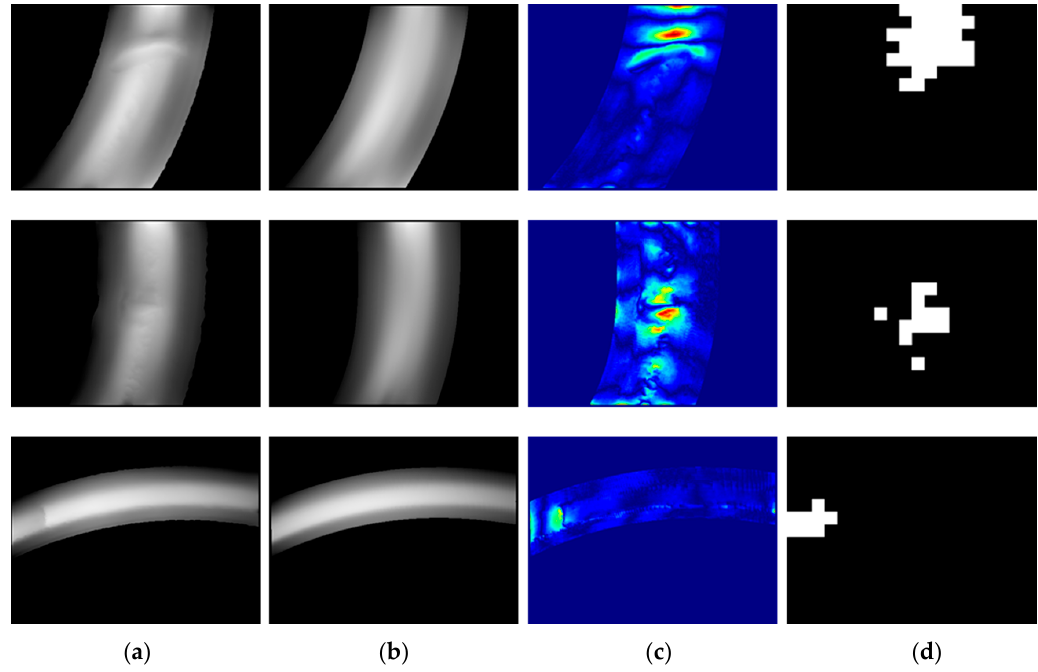
Figure 19. Defects detection processing with photometric stereo model M P . ( a ) Photometric stereo model M P (Gray scale), those models reconstructed by corresponding images in Figure 18; ( b ) Smooth surface model M S (Gray scale), this model is the smooth version of Photometric stereo model M P , create by the method in this paper Section 2.2; ( c ) the deviation model M D , this model created by subtracting ( a , b ) (jet color map and mapped into range 0~500 µ m); ( d ) Candidate area (Binary images), which is produced by sliding windows with ( c ).